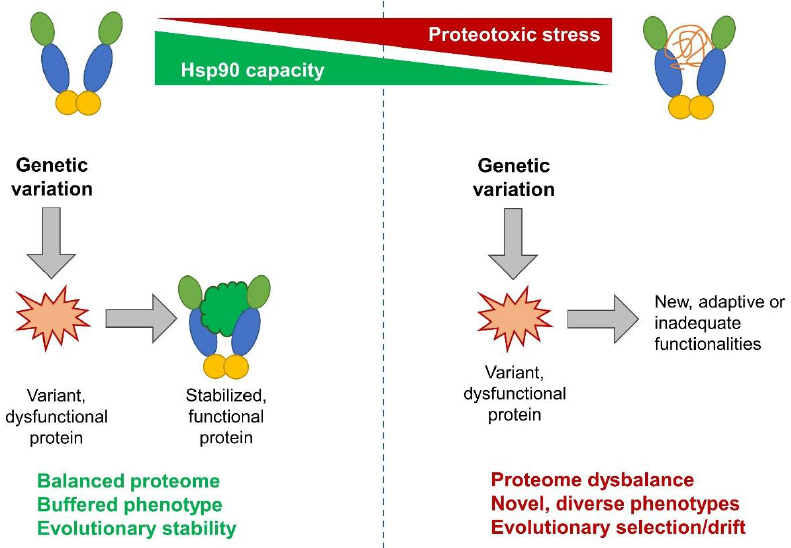
Figure 5. Hsp90 ensures proteome stability and acts as an evolutionary capacitor. Adequate Hsp90 capacity masks the effects of genetic variation by stabilizing mutant proteins and ensuring their functionality. Stressful conditions reduce Hsp90 capacity to inadequate levels, which releases cryp- tic variations, which may result in sudden changes in protein networks and in the phenotype. Non- adaptive changes are purged, whereas adaptive ones are selected by natural selection. Thus, Hsp90 is a stress-responsive regulator of evolutionary adaptation of the proteome.